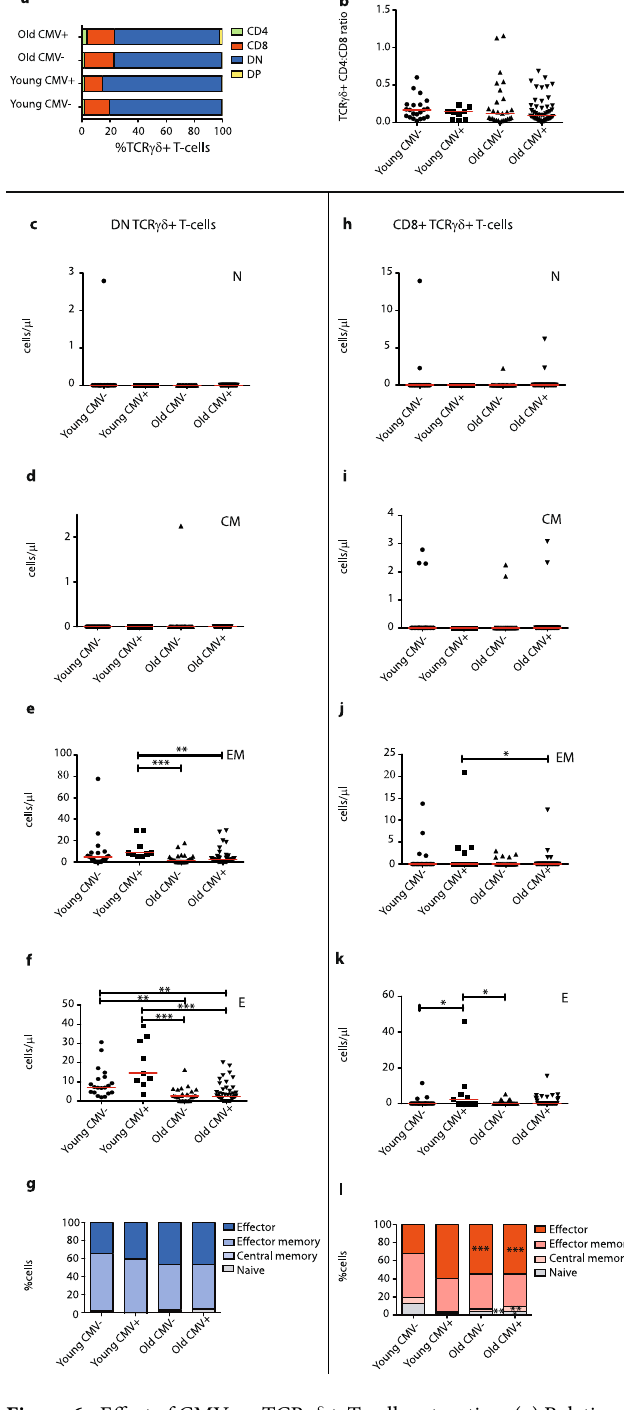
Figure 6. Effect of CMV on TCR γδ+ T-cell maturation. ( a ) Relative visualization of CD4 and CD8 single- positive, double-positive (DP, CD4 + CD8 + ) and double-negative (DN, CD4 − CD8 − ) distribution within the total TCR γδ+ T-cell compartment between different age and CMV groups. ( b ) CD4:CD8 ratios in total TCR γδ+ T-cell population. ( c ) Absolute numbers of DN naive (CD45RO − CD197 + ), ( d ) central memory (CD45RO + CD197 + ), ( e ) effector memory (CD45RO + CD197 − , Temro) and ( f ) effector (CD45RO − CD197 − , Temra) TCR γδ+ T-cells. ( g ) Relative distributions of maturation subsets of DN TCR γδ+ T-cells depicted in stacked bar plots. ( h ) Absolute numbers of CD8 + naive, ( i ) central memory, ( j ) effector memory and ( k ) effector CD8 + TCR γδ+ T-cells. ( l ) Relative distributions of maturation subsets of CD8 + TCR γδ+ T-cells depicted in stacked bar plots. Ratios and absolute numbers are indicated in scatter plots indicated with the median. Significance was tested by a Kruskal-Wallis test, followed by a post-Dunn’s test for correction for multiple testing. Significance for the Dunn’s test is indicated in the plots: * p < 0.05; ** p < 0.01, *** p <